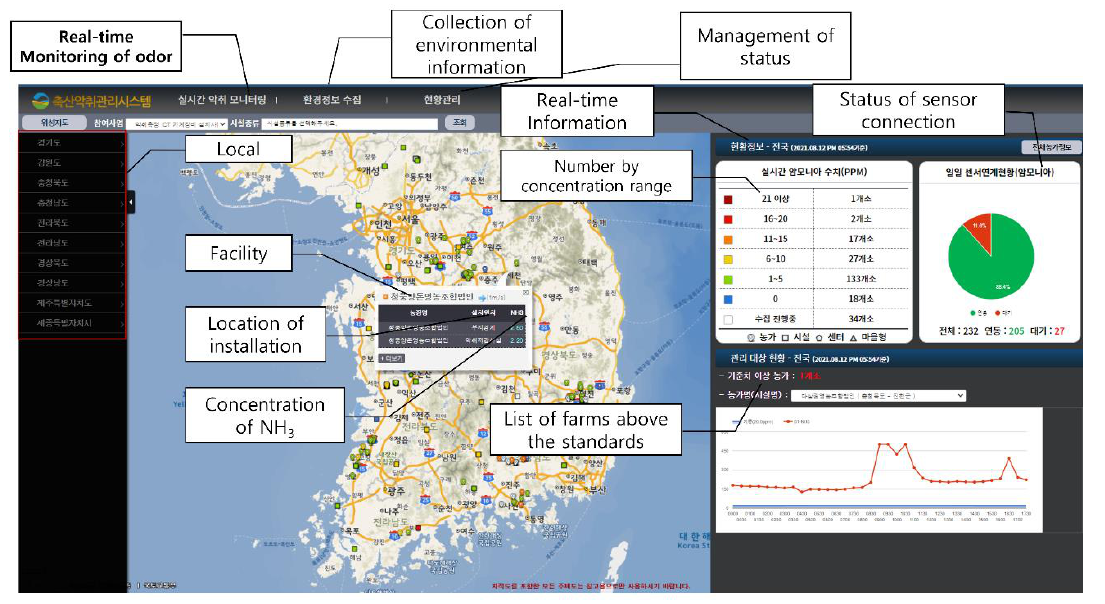
Figure 3. The main page of the livestock odor control system. The location where the sensor is installed and the real-time ammonia level through GIS can be checked, and also the ammonia gen- eration trends of the farm can be